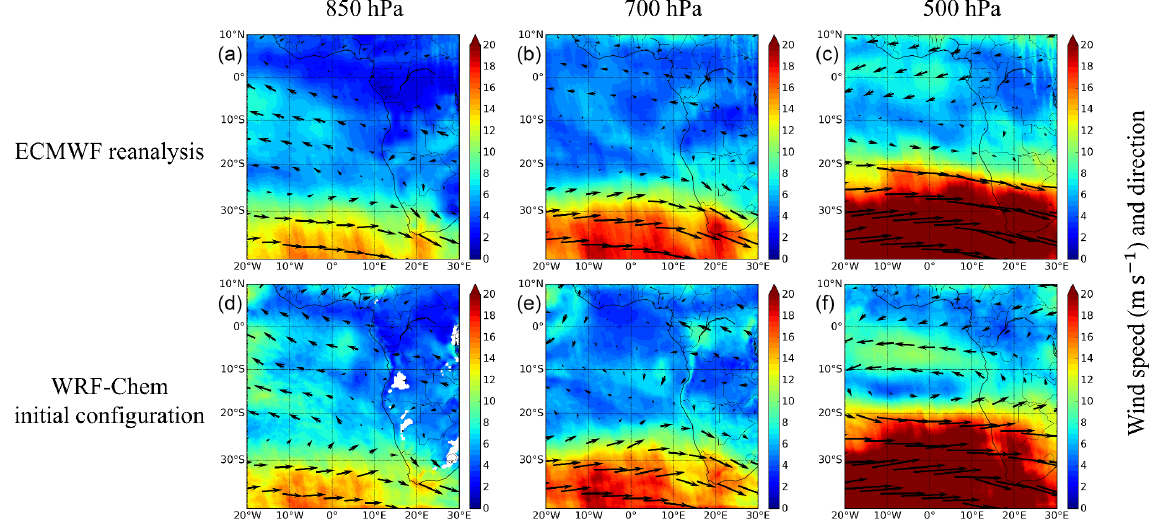
Figure 4. Monthly averaged wind speed (ms − 1 ) and direction at 850hPa (a, d) , 700hPa (b, e) and 500hPa (c, f) from ECMWF ERA-Interim reanalysis (a, b, c) and simulated with the WRF-Chem initial configuration (d, e, f) for July 2008.